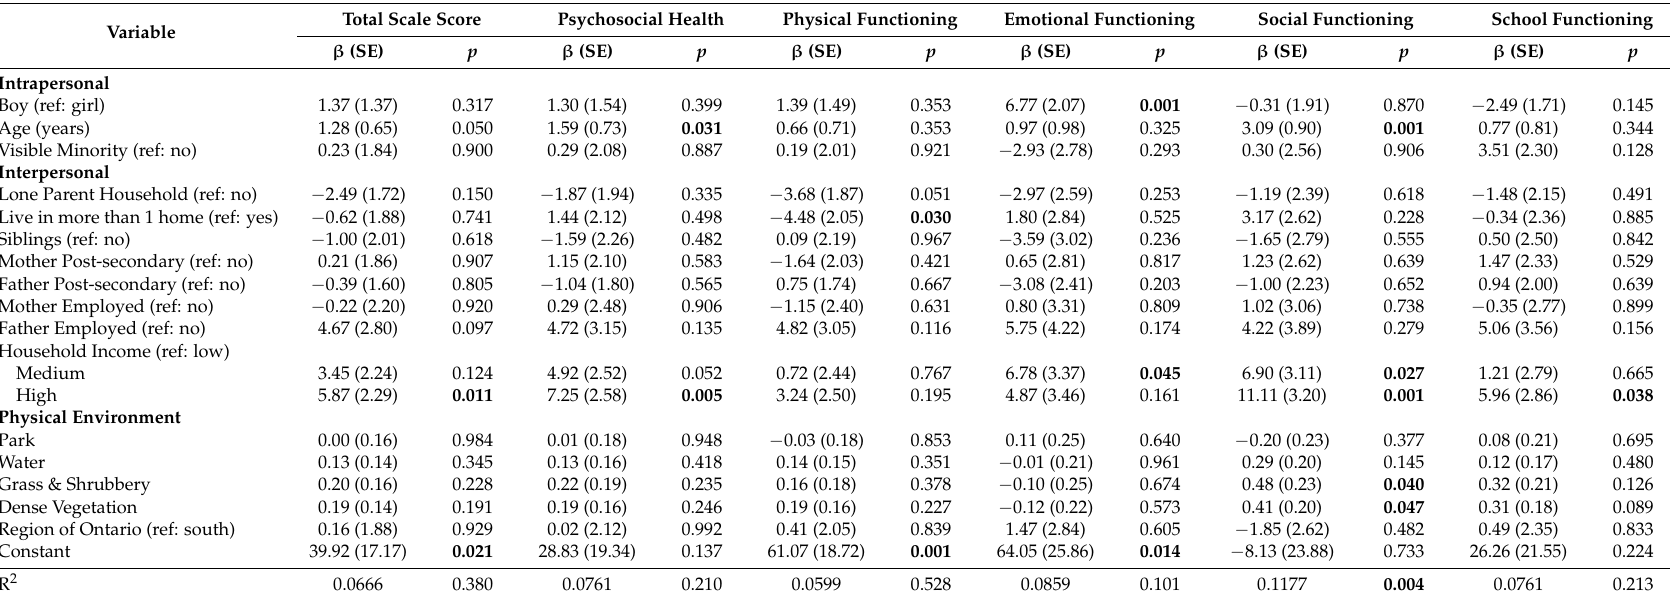
Table 4. Results of full models assessing associations between all independent variables and HRQOL indices at a 500M buffer in the rural population.